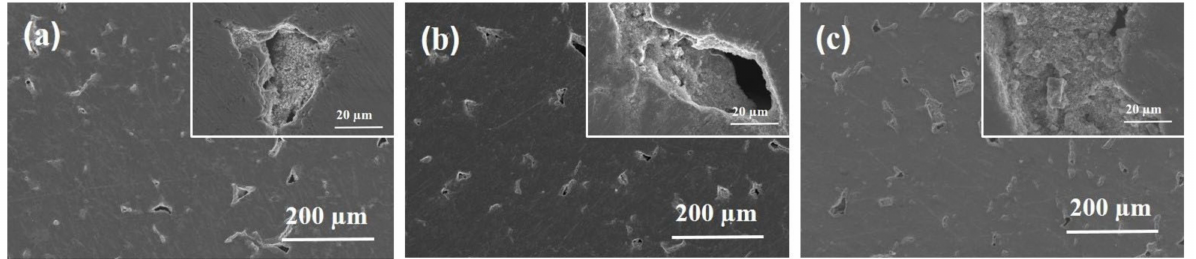
Figure 6. SEM micrographs of the deposits obtained on porous Ti substrates by the single-step procedure starting from suspensions of TiN-micro (EPD TiN-01 ( a ), TiN-nano (EPD TiN-02 ( b )) and TiN-nano/micro (EPD TiN-03, ( c ) powders after 1200 s of deposition time. The respective high magnification images are shown within the inset of the images.